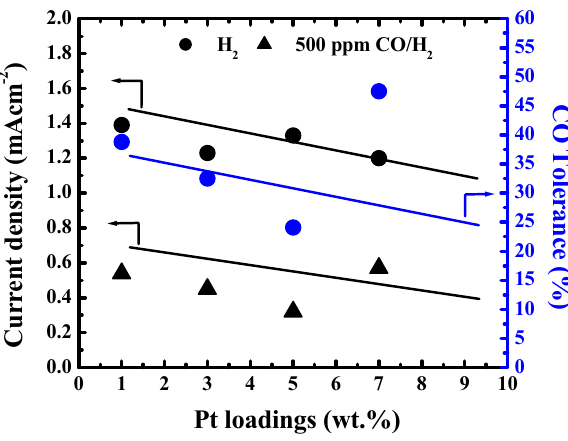
Figure 8. Graph current density and CO tolerance vs Pt loading on GNS (wt.%) (CV measurement).